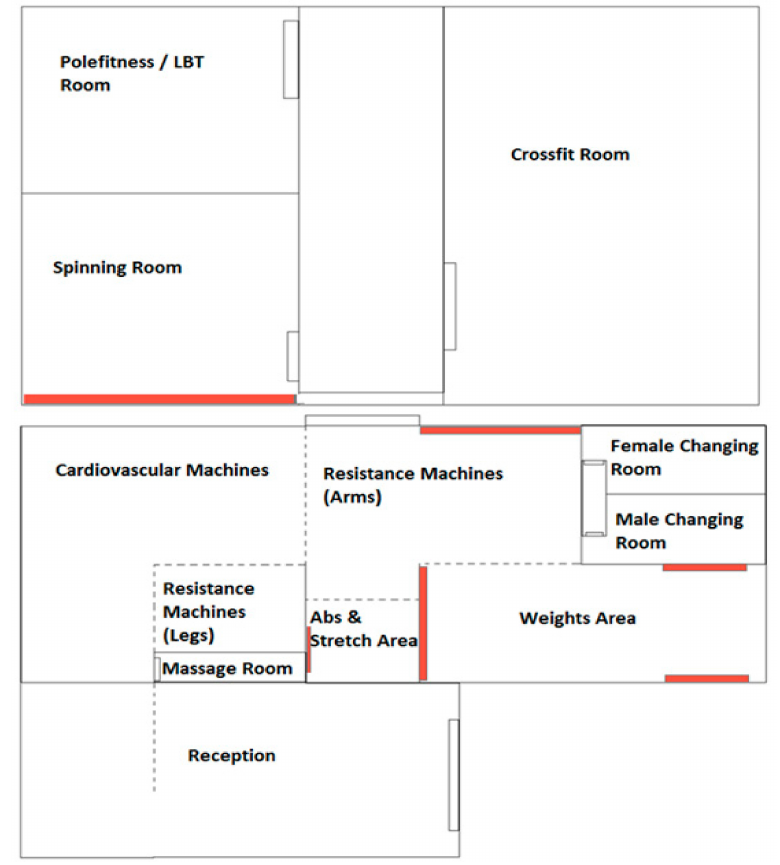
Figure 1. The research location (gym) layout